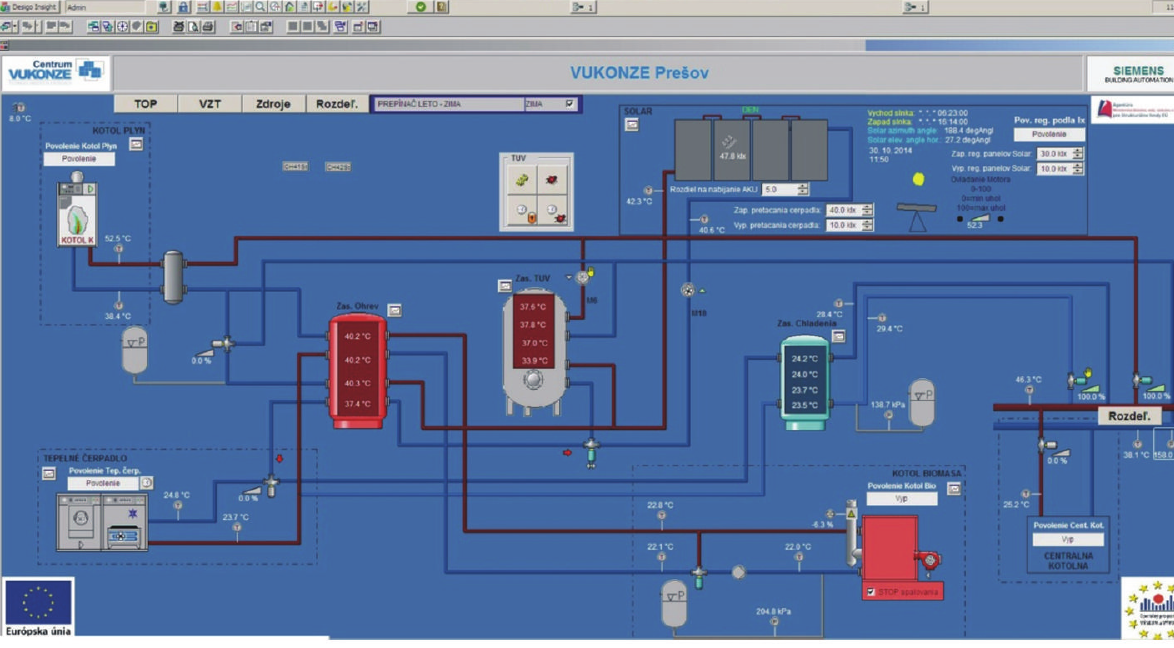
Figure 14: The screen of the control